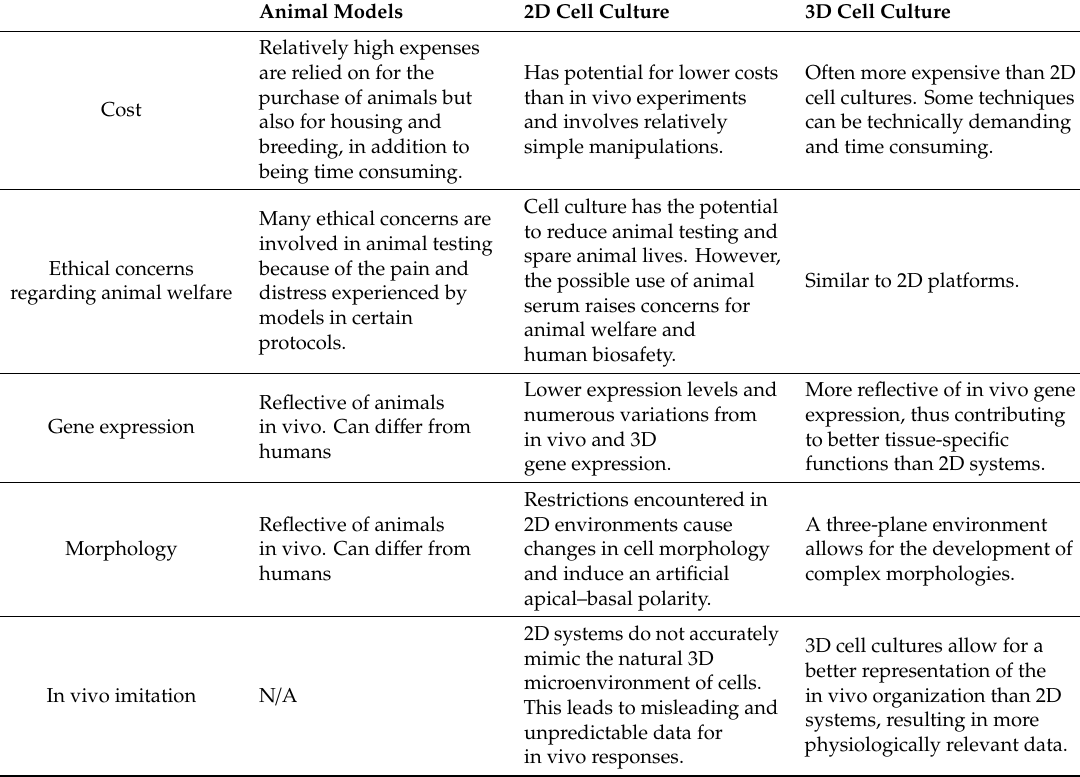
Table 1. Characteristics of animal models compared to 2D and 3D cell culture